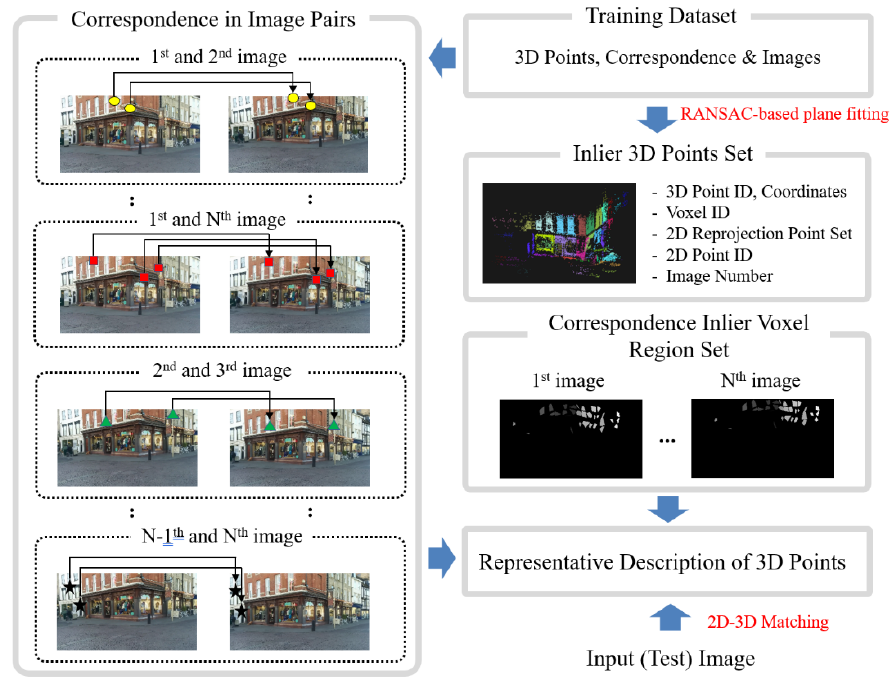
Figure 3. Overview of the training dataset architecture.